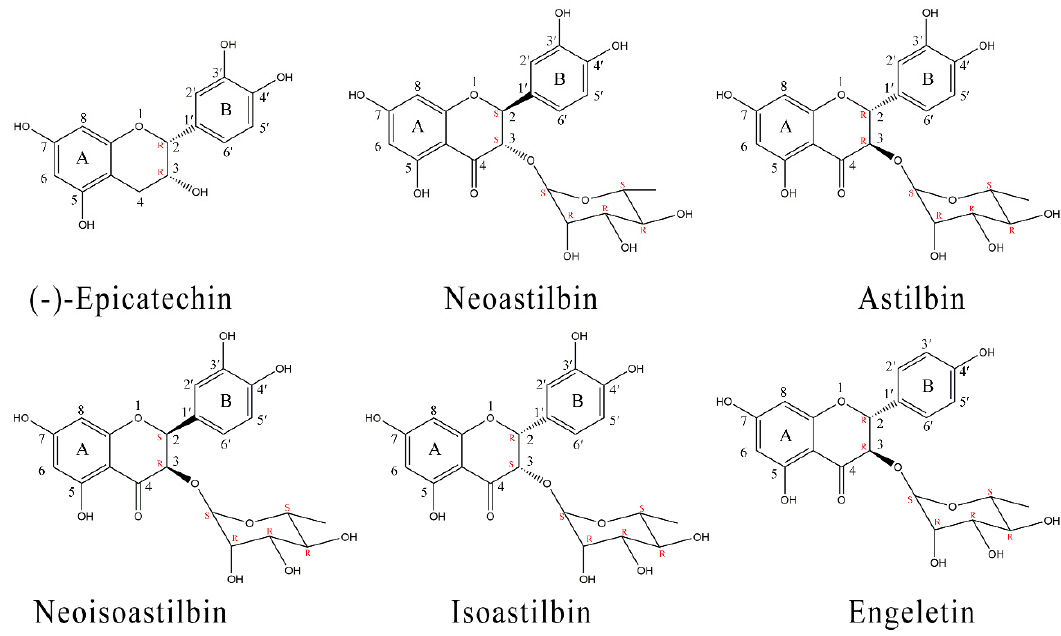
Figure 2. Chemical structures of six flavonoids in Smilax glabra flavonoids extract (SGF).